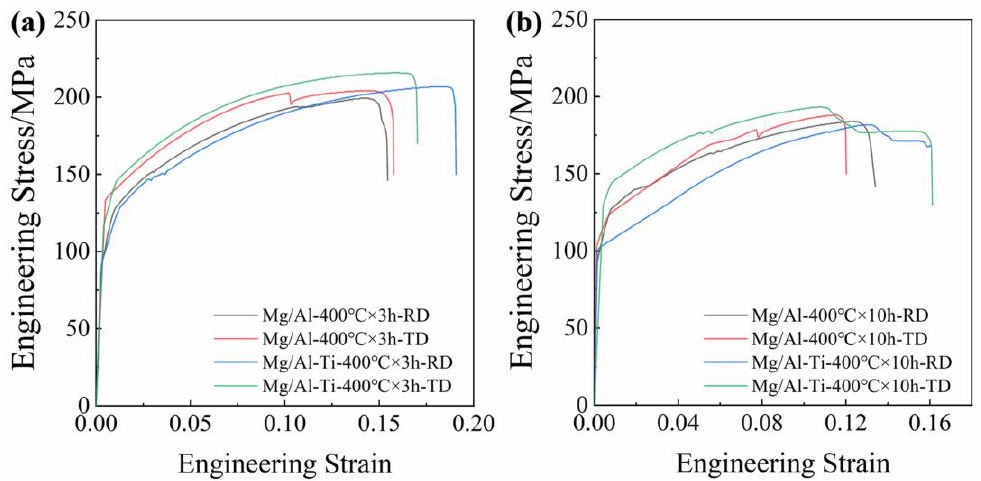
Figure 9. Engineering stress–strain curves under tension along the RD and TD of composite sheets: ( a ) after annealing at 400 °C for 3 h, and ( b ) after annealing at 400 °C for 10 h. Table 2. Tensile properties of composite sheets after annealing at 400 °C for 3 h and 10 h.